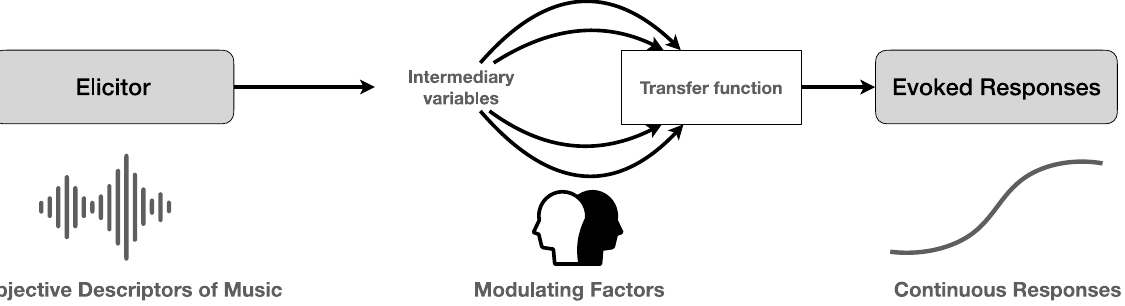
Figure 1. Overview of the elicitor–response schematic with modulating factors and transfer func-